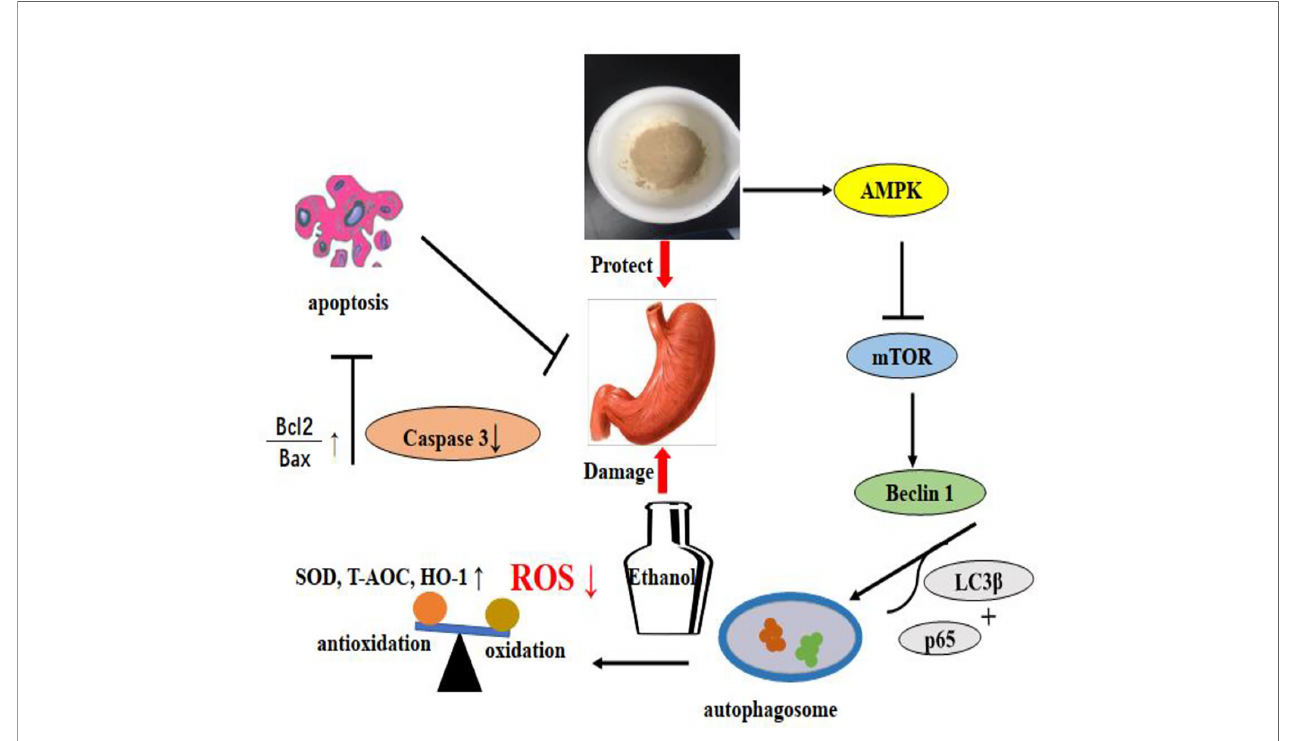
FIGURE 12 | LDOP-1 protected against ethanol-induced gastric mucosal injury via AMPK/mTOR signaling